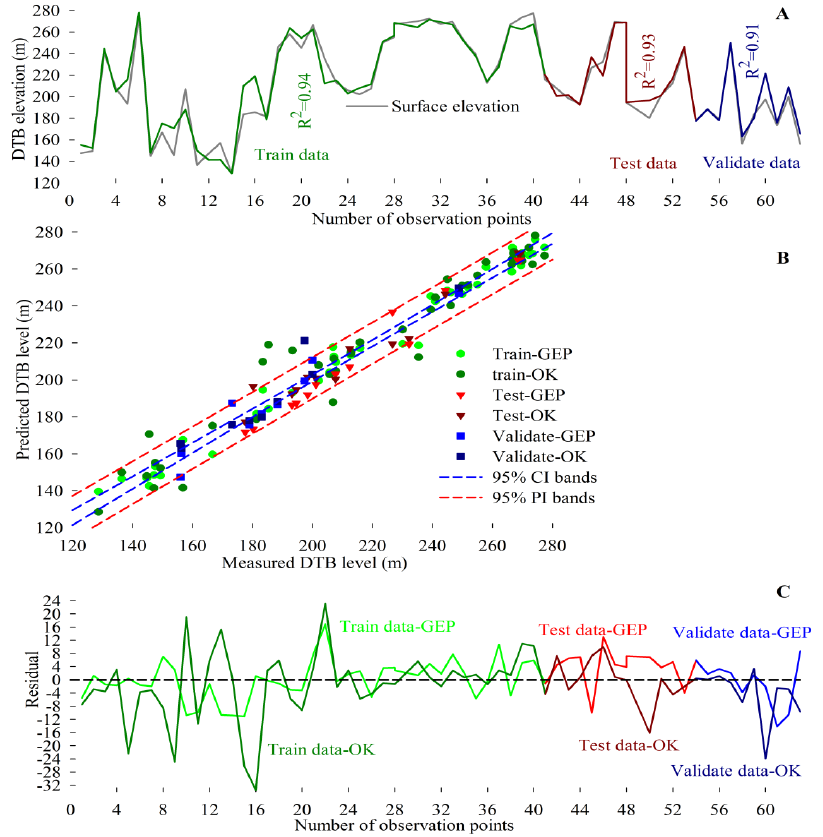
Figure 10. Results of OK ( A ), predictability of OK and GEP using CI and PI ( B ) and compared residuals ( C ).